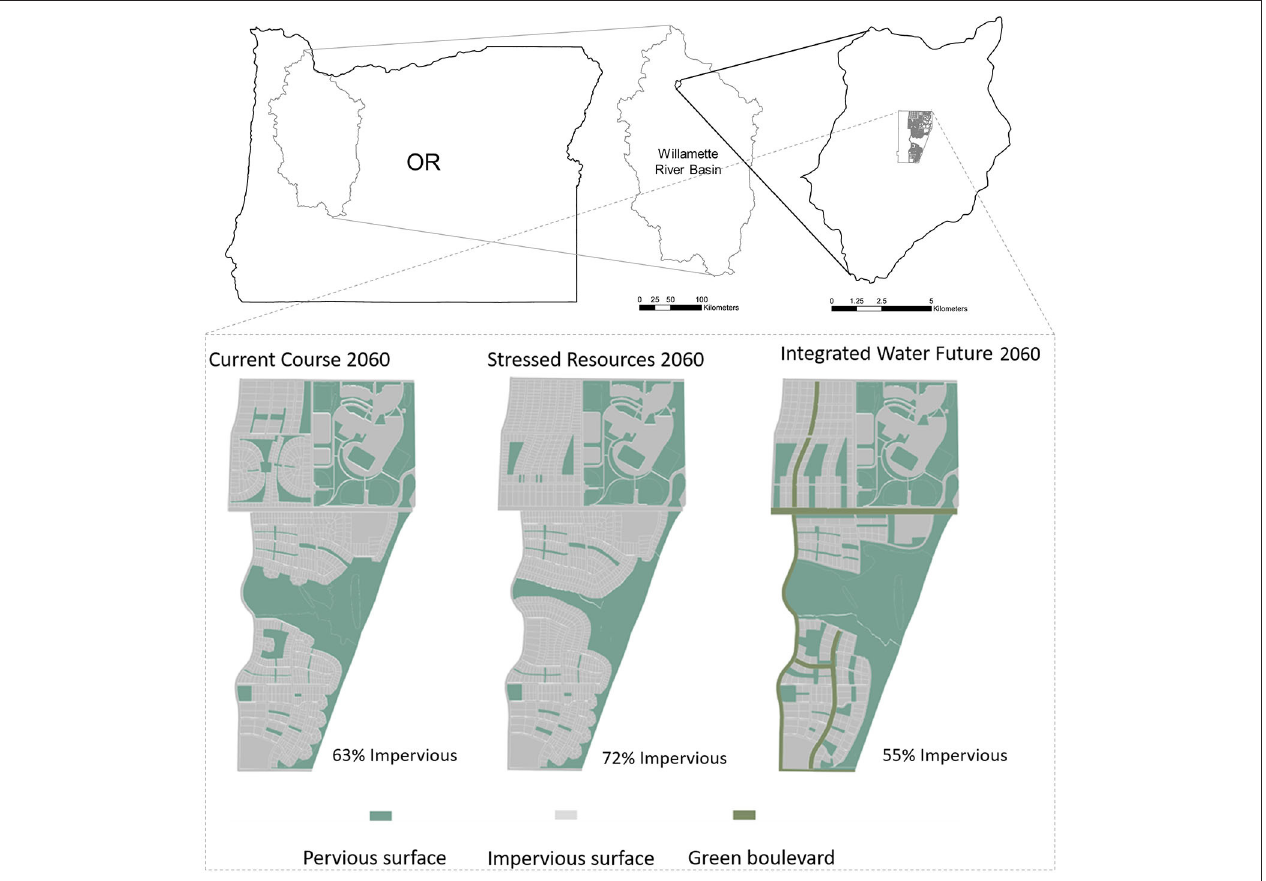
FIGURE 1 | Map showing the location of the West Sherwood neighborhood within the Chicken Creek Watershed, which is located within the Willamette River Basin in the state of Oregon. The three alternative future scenarios are shown for the West Sherwood neighborhood, from left to right: Current Course, Stressed Resources, and Integrated Water future scenarios ( Supplementary Figure 1 illustrates the delineation of the sub-catchments used in the SWMM simulations and detailed land use